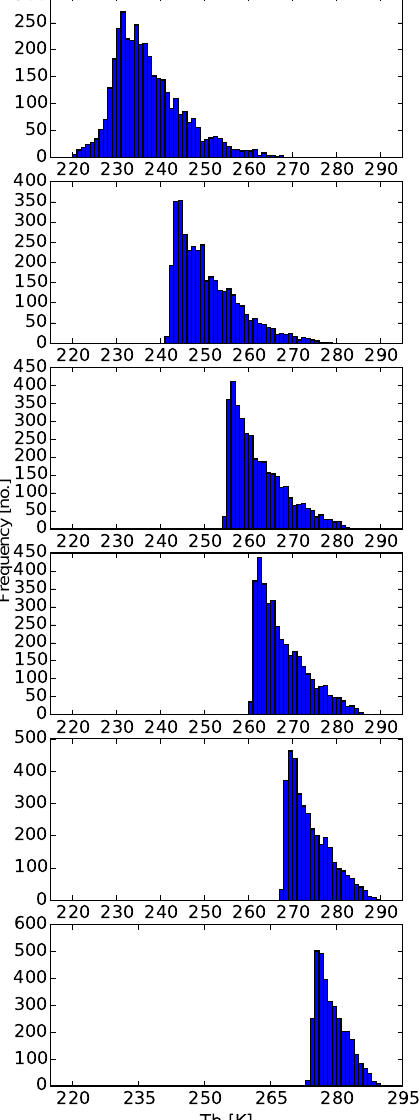
Figure 3. Histograms for the distribution of Tb’s that are not affected by the surface. The panels from top to bottom are for SAPHIR channel 1 (upper troposphere) to channel 6 (lower tropo- sphere), respectively.